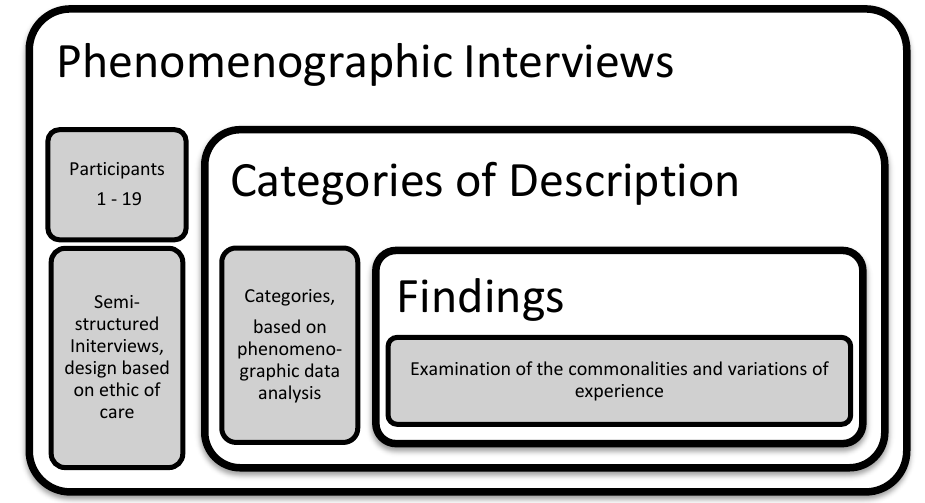
Figure 2. Research design for project. From The Ability to Access Post-Secondary Education: Adult Learners’ Conceptions of Choosing Online Learning (p. 73), by K. Rasmussen, 2015, Lancaster University, UK. Copyright 2015 by Kari